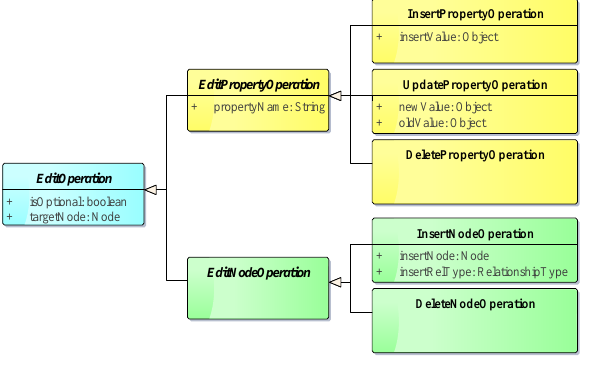
Figure 9. A UML class diagram of edit operations.